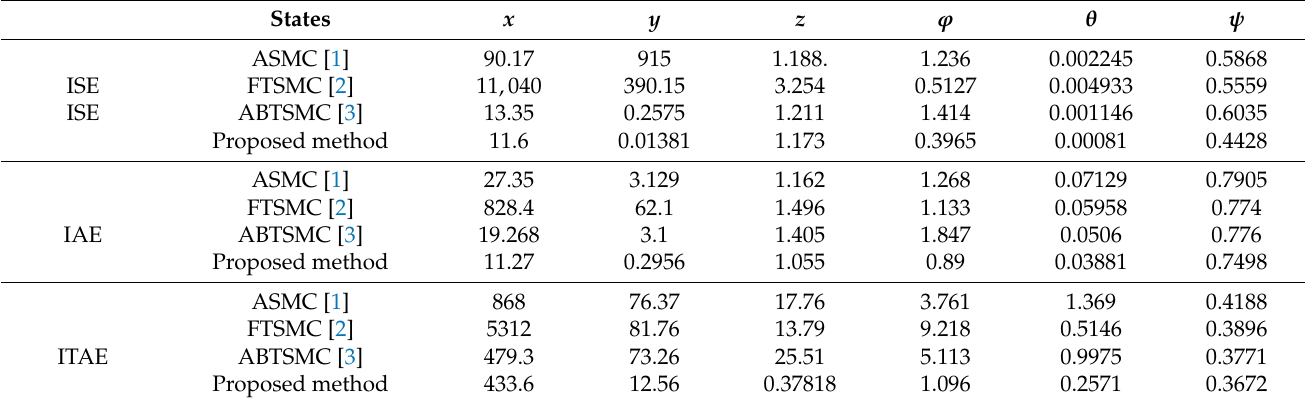
Table 3. Performance indices under 40% sinusoidal fault actuators 2 and